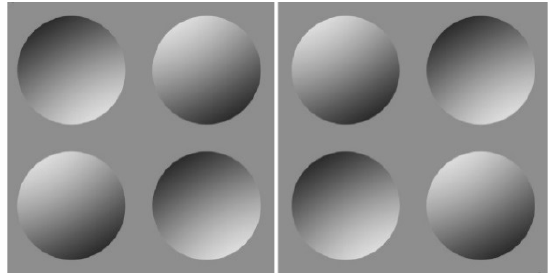
Figure 3: Convex and concave perception based on light direction, from (Stone et al.,